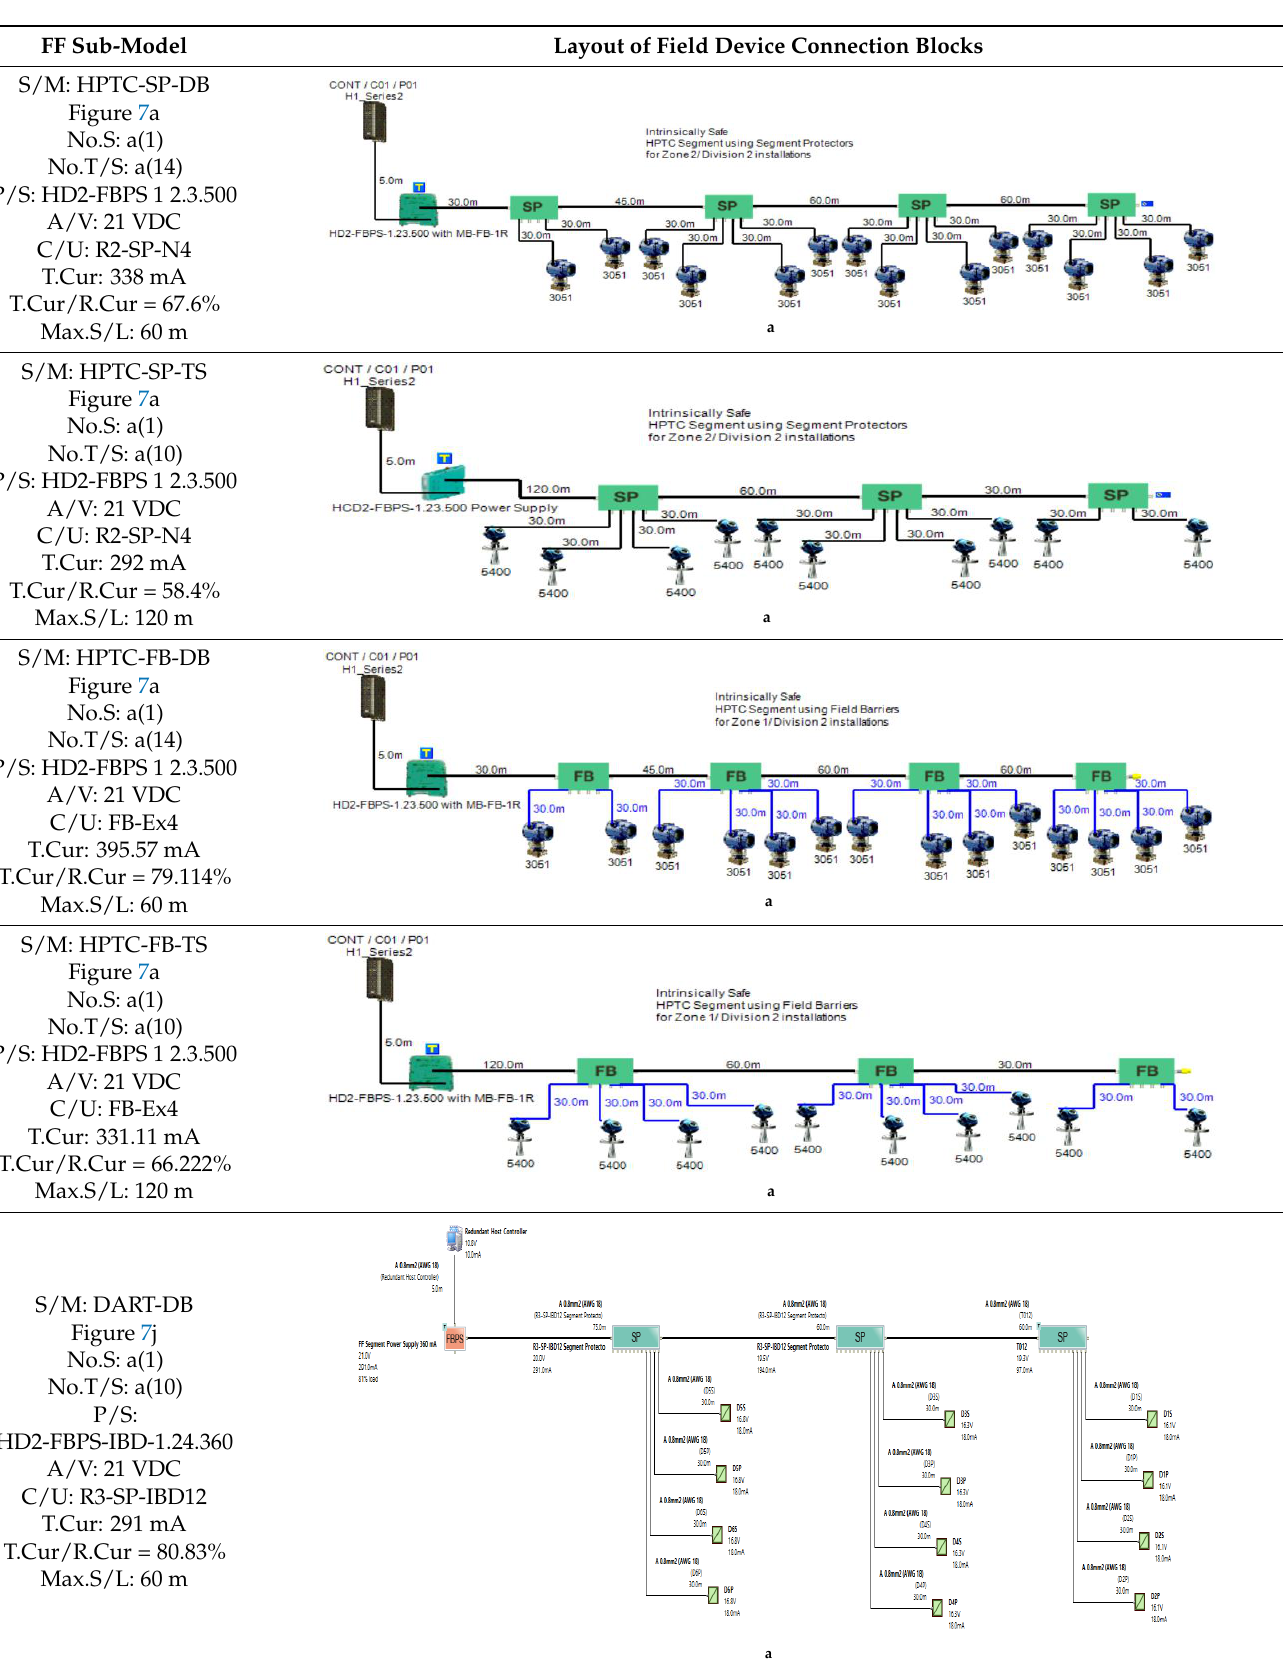
Figure 7i No.S: a(2),